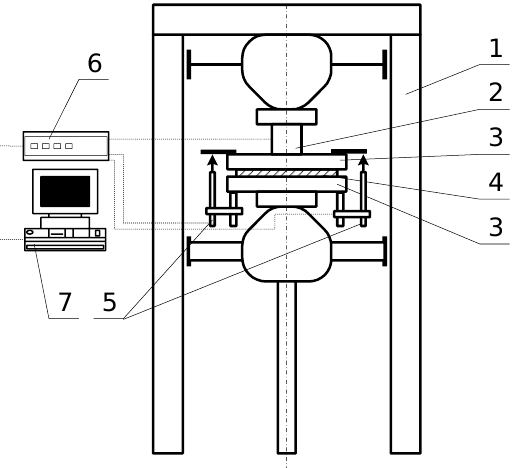
Figure 8. Pressing test set up. 1 — pressing machine, 2 — force measuring cell, 3 — clamping structure, 4 — tested specimen, 5 — displacement transmitter, 6 — Quantum X A/D measurement data collector, 7 — computer.